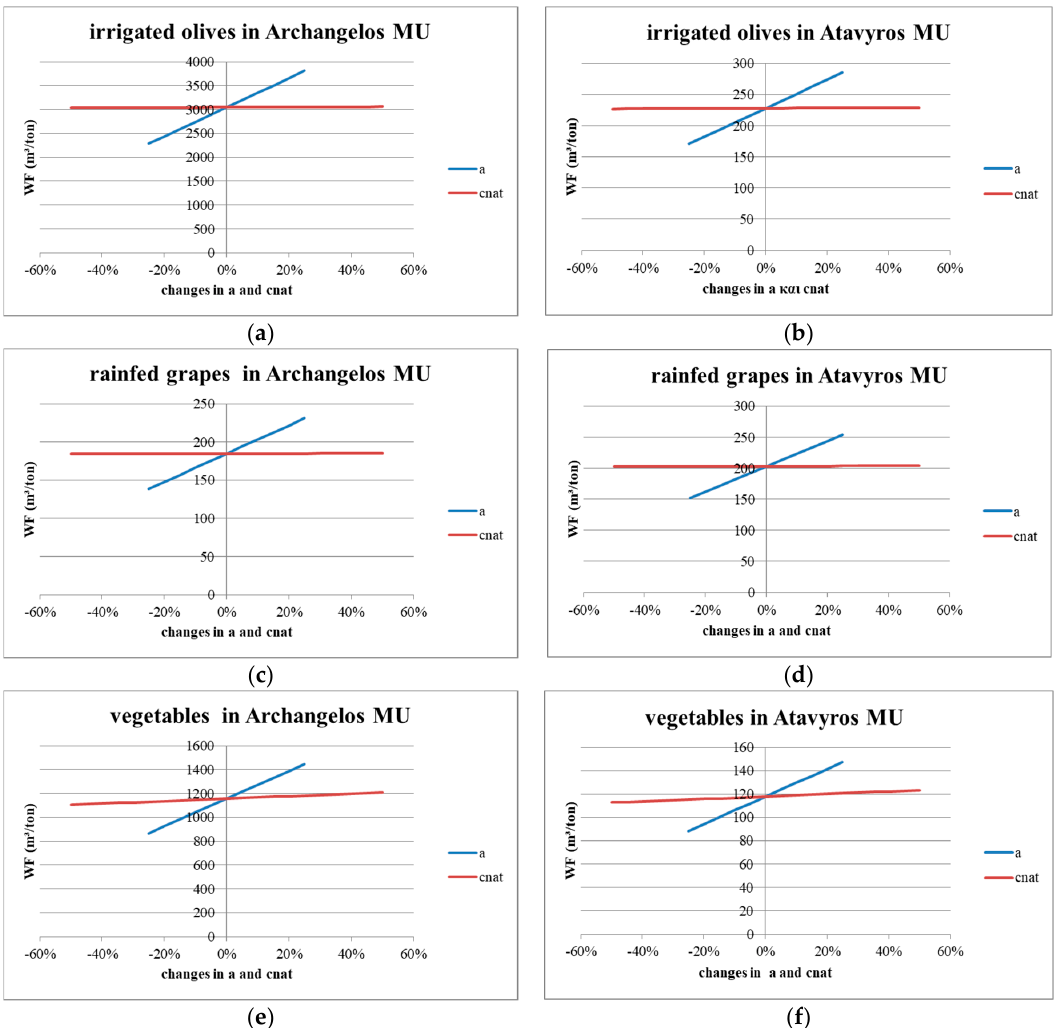
Figure 8. Sensitivity of gray WF to changes of a and c nat for 2013: ( a ) irrigated olives in Archangelos MU; ( b ) irrigated olives in Atavyros MU; ( c ) rainfed grapes in Archangelos MU; ( d ) rainfed grapes in Atavyros MU; ( e ) vegetables in Archangelos MU; and ( f ) vegetables in Atavyros MU.